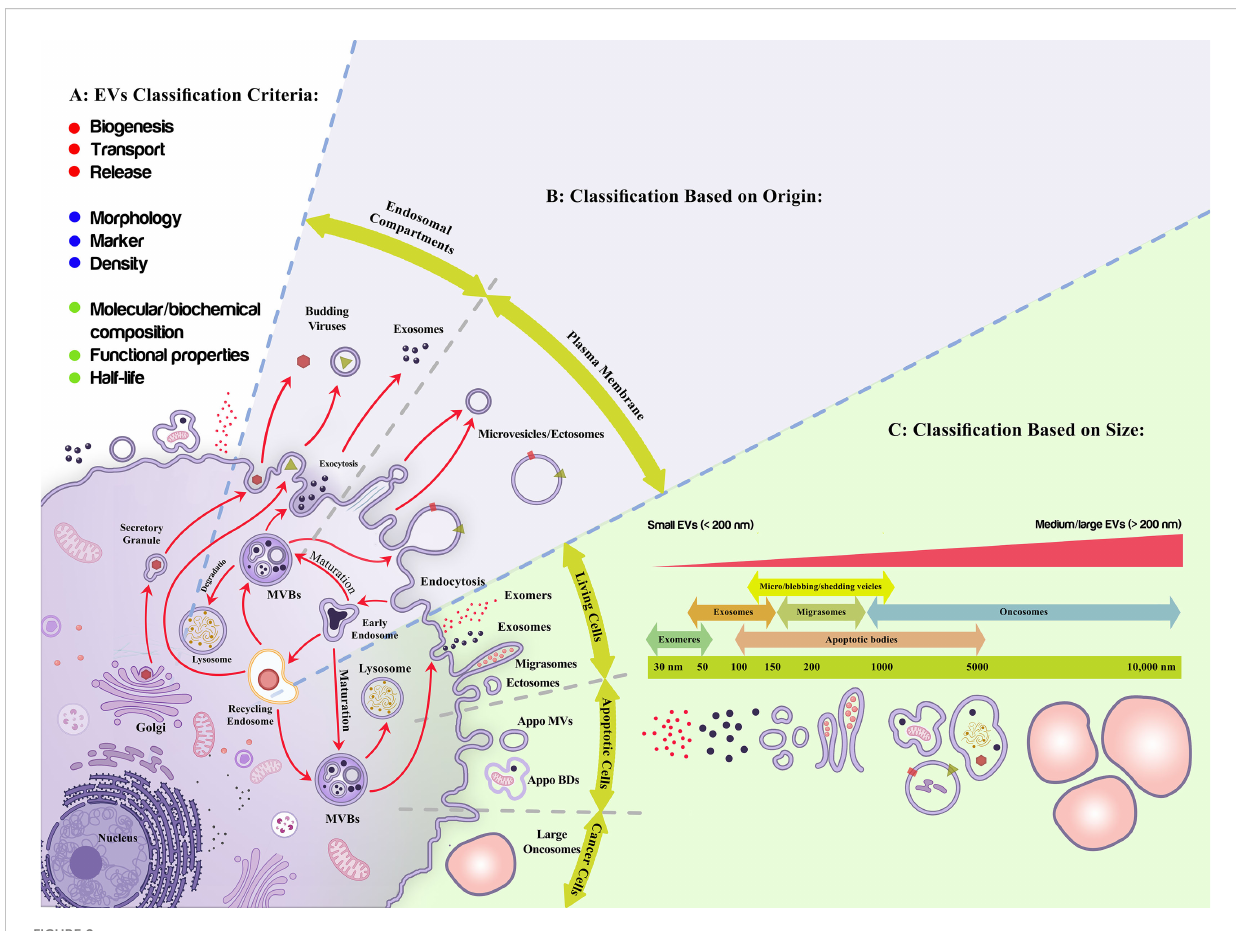
FIGURE 2 Extracellular vesicles classi fi cation. (A) Different criteria have been proposed to classify Extracellular vesicles (EVs) including production mechanism (biogenesis, transport, release), morphology, markers, density, half-life, molecular composition, and functional properties; among which their origin (B) , and size (C) are more applicable due to their quantitative modality and functional consequences, respectively. (B) As it is shown, exosomes are the nano-entities released upon the exocytosis of multivesicular bodies while ectosomes/microvesicles are produced upon the assembly of plasma membrane into the membranous vesicles. (C) Live cells, apoptotic cells, and cancerous cells produce nano-size extracellular vesicles with different characteristics. These vesicles have an overlapping size distribution, gradually increased from exomeres to oncosomes. EVs are also classi fi ed as small (<200 nm) and large EVs (>200